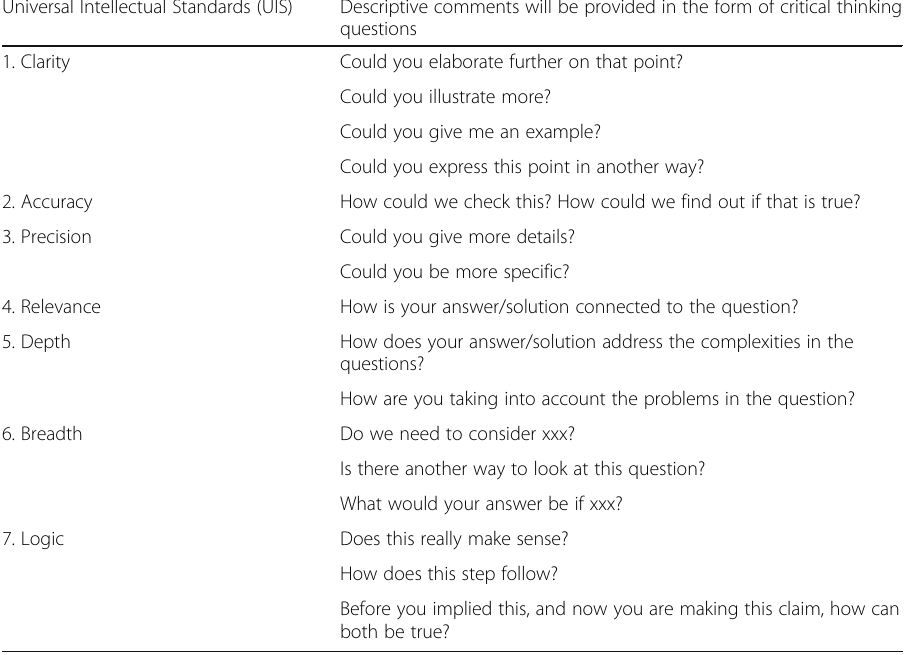
Table 1 Framework for written descriptive feedback adopted in the study Universal Intellectual Standards (UIS)